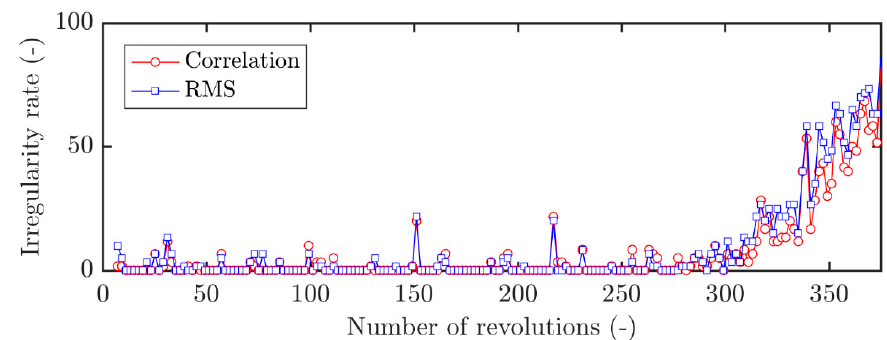
Figure 10. Irregularity rate evolution computed from the Correlation and the RMS (surveillance threshold respectively equal to 0.012 and 0.021). Sensor location: (x, θ ) = ( − 0.06.C x , 90 ◦ ); moderate throttling speed.